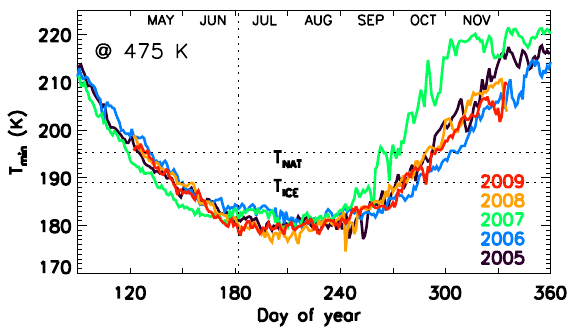
Fig. 7. ECMWF daily minimum temperatures within 50–90 ◦ S at 475K for 2005–2009. The horizontal lines represent the T NAT and T ICE thresholds. The dotted vertical line represents 1